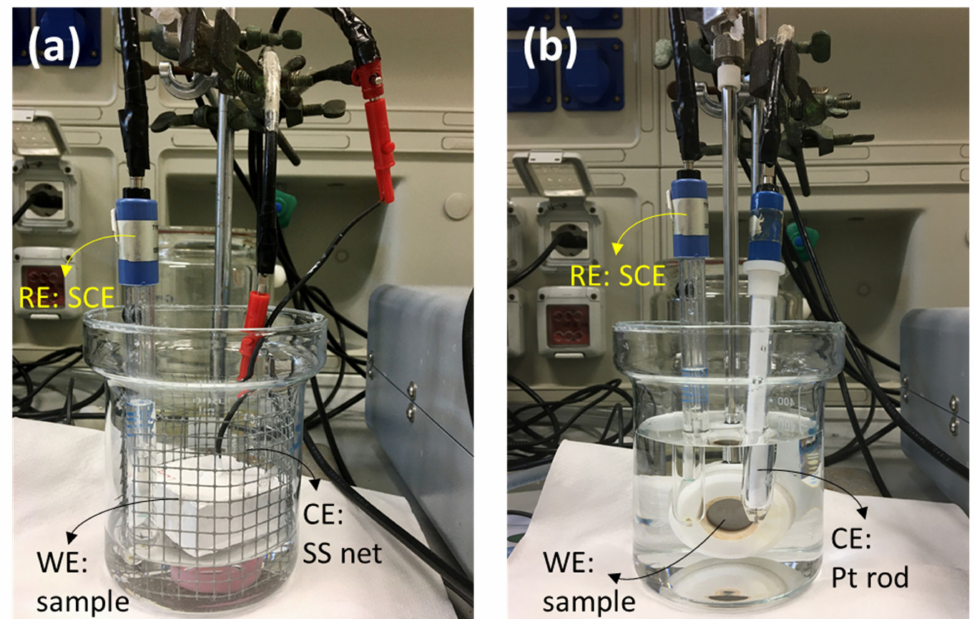
Figure 2. Electrochemical set up consisting of the conventional three-electrode cell for anodic polarization curves of ( a ) coated steel samples with LWM or M mortars and ( b ) steel samples tested in different